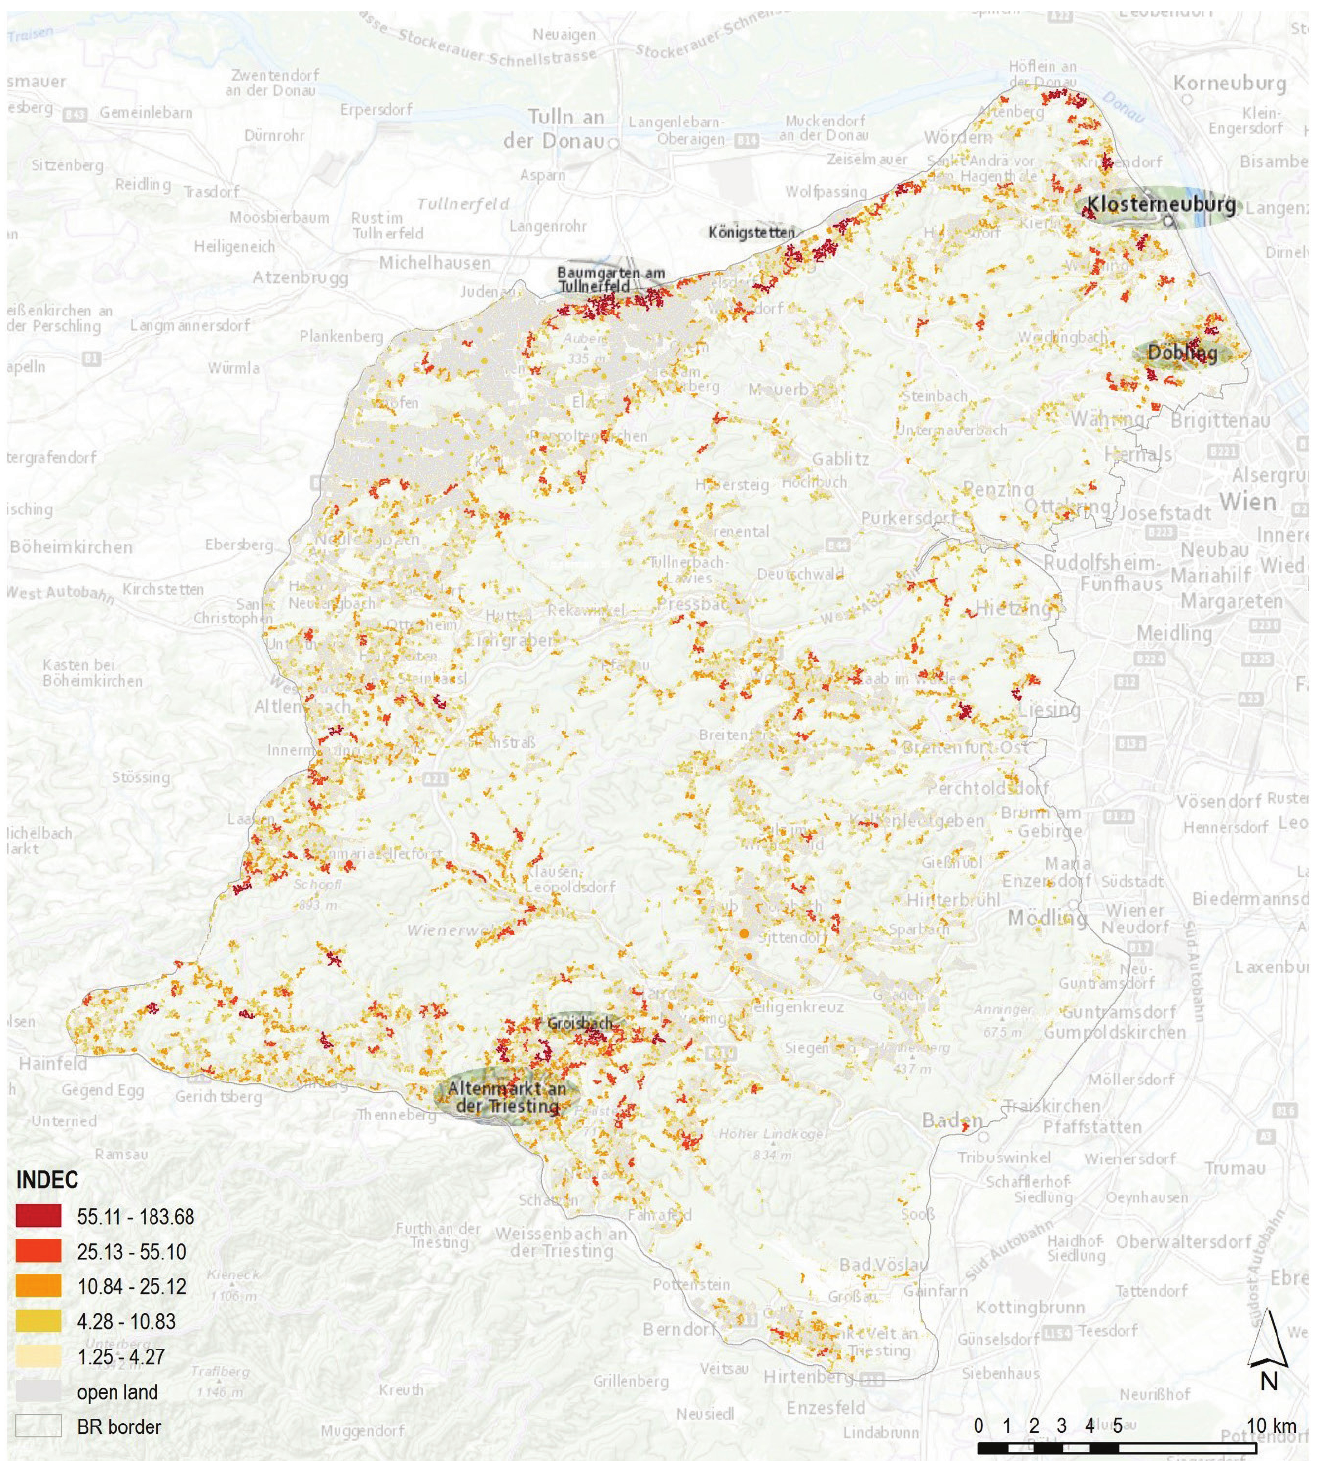
Figure 7: Pollination capacity in the Wienerwald Biosphere Reserve. The colour ramp distinguishes clusters of different INtensity and DEnsity Capacity (INDEC). Data sources: © OpenStreetMap (2018); Staudinger et al. (2014); Wienerwald Tourismus GmbH (2018); www.basemap.at (2018). EPSG: